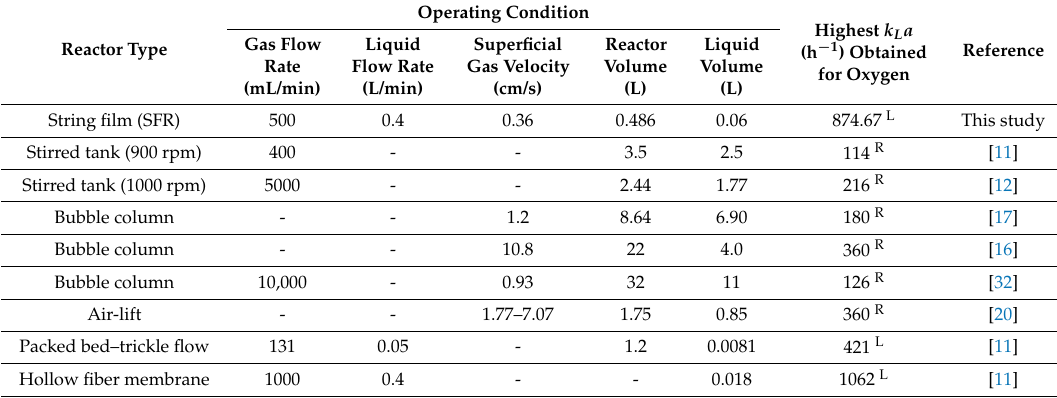
Figure 5. Comparison of the mass transfer characteristics in the SFR using different feeding gases: ( a ) the volumetric mass transfer coefficients for oxygen (left side) and methane (right side) and ( b ) the measured (closed circle) and estimated (open circle) volumetric mass transfer coefficients obtained for methane. Table 2. Mass transfer coefficients for oxygen for the SFR and other reactor